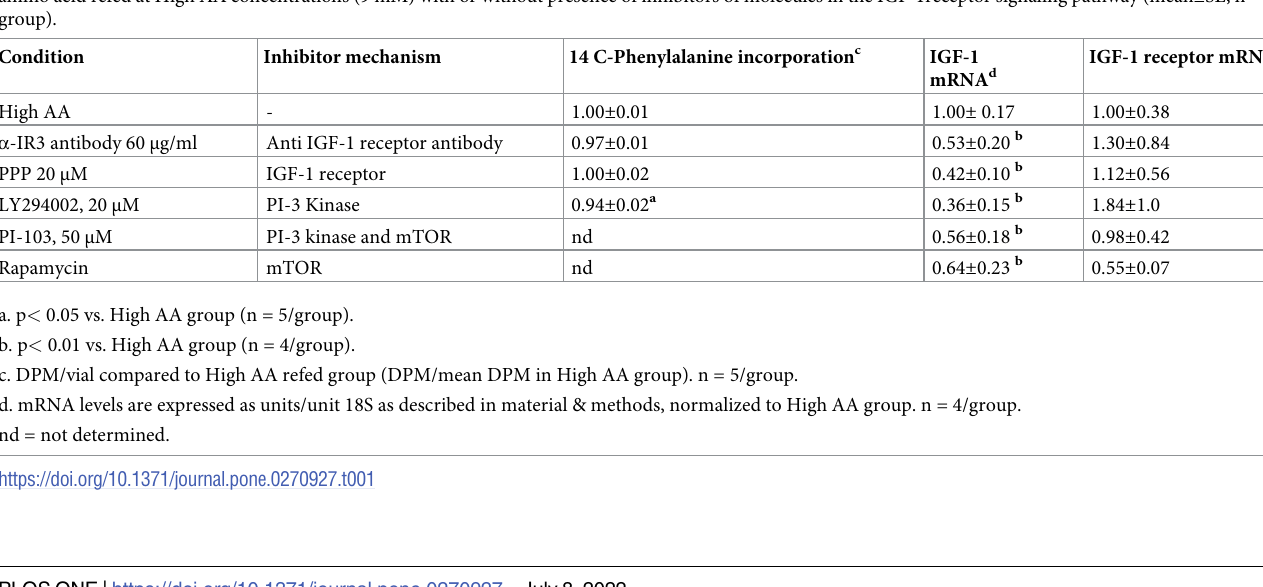
PI-3 kinase inhibition was obtained by either LY294002, or PI-103 which is reported to also suppress mTOR signaling. Rapamycin was used as an alternative of mTOR inhibition. IGF-1 mRNA levels were significantly lower (~30–40%) in non-proliferating cells refed